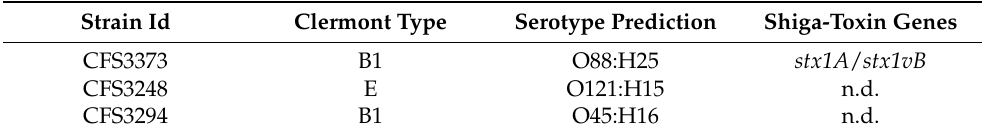
Table 1. Strains’ non-O157 serotypes associated with serious illness and major outbreaks. Strain Id Clermont Type Serotype Prediction Shiga-Toxin Genes CFS3373 B1 O88:H25 stx1A / stx1vB CFS3248 E O121:H15 n.d. CFS3294 B1 O45:H16